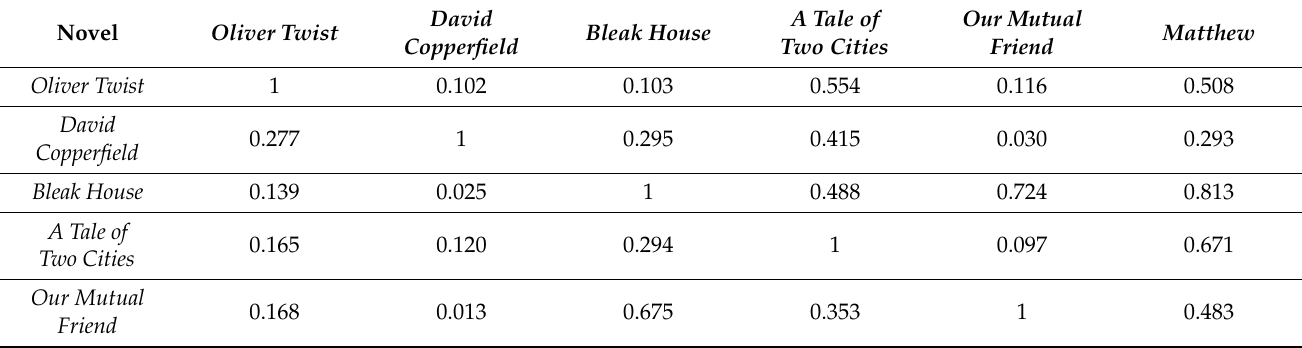
Table 11. Likeness index I L = I C between the indicated literary works, sentences channel. The work in the first line indicates the output text; the text in the first column indicates the input text (regression line given in Table 3). For example, in the channel Our Mutual Friend → Bleak House , I L = 0.675, while in the reverse channel, Bleak House → Our Mutual Friend , I L = 0.724 .